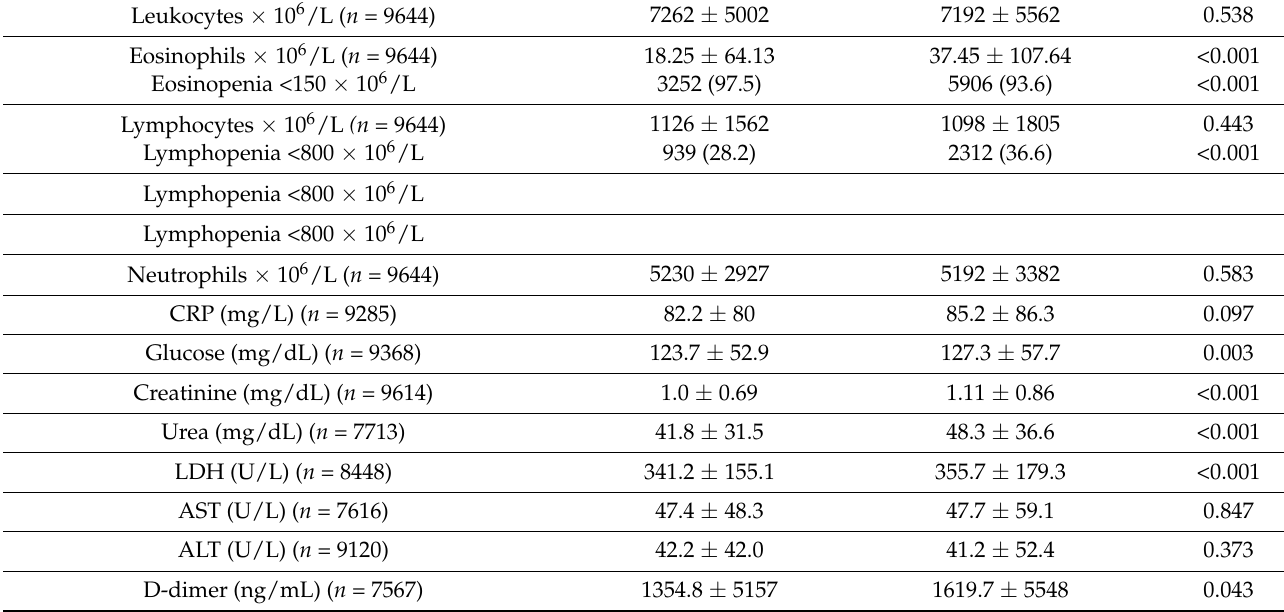
COPD: chronic obstructive pulmonary disease. Comorbidity was measured using the Charlson Comorbidity Index. brpm: breaths per minute. SBP: systolic blood pressure. mmHg: millimetres of mercury. bpm: beats per minute. qSOFA: quick sequential organ failure assessment. CRP: C-reactive protein. LDH: lactate dehydrogenase. AST: aspartate aminotransferase. ALT: alanine aminotransferase. Categorical variables are expressed as N (%), quantitative variables as mean ±